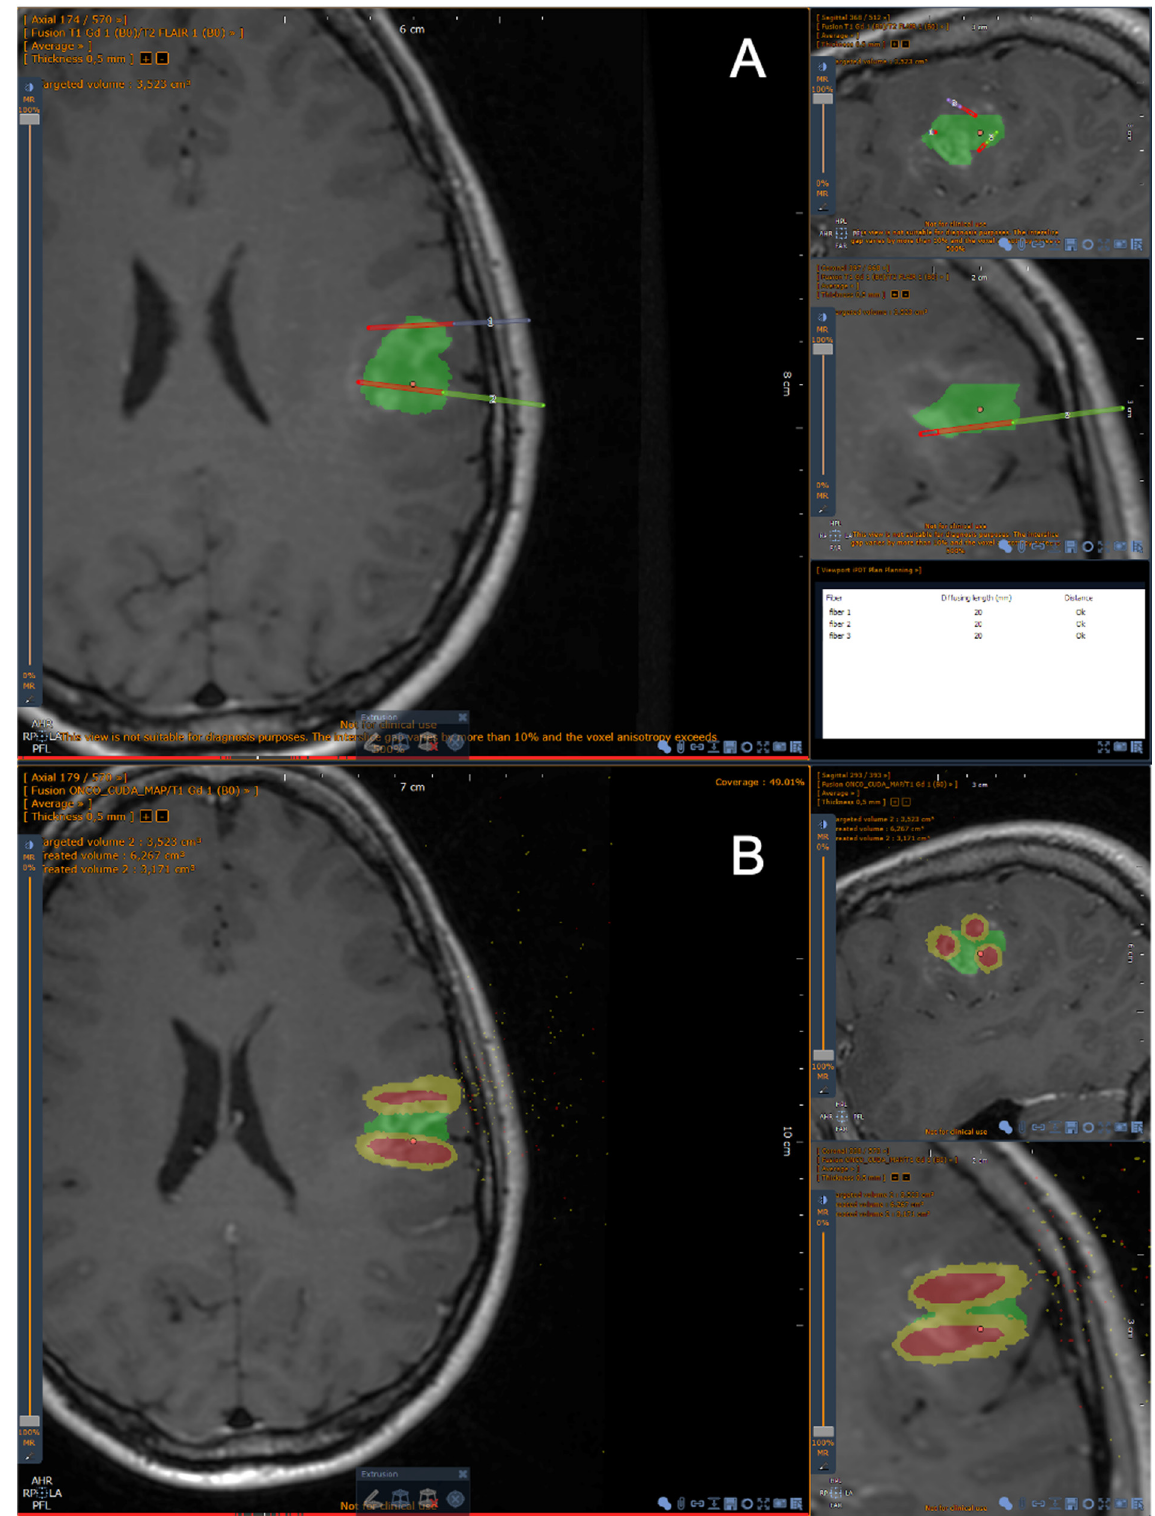
Figure 2. Screenshots from the iPDT TPS for GBM. ( A ) Brain MRI, T1 after gadolinium infusion. The green zone corresponds to the target volume. The diffusing part of each fiber is displayed in red. ( B ) The effective treated volume is displayed in yellow, receiving at least 25 J/cm 2 . The red volume around each fiber corresponds to a volume receiving an energy >250 J/cm 2 . In this snapshot, the optical fibers have a 2 cm diffusing part. Only one fiber is able to cover a volume superior to 1 cm 3 (here: 1.166 cm 3 , taking into account the optical parameters of all brain tissues).